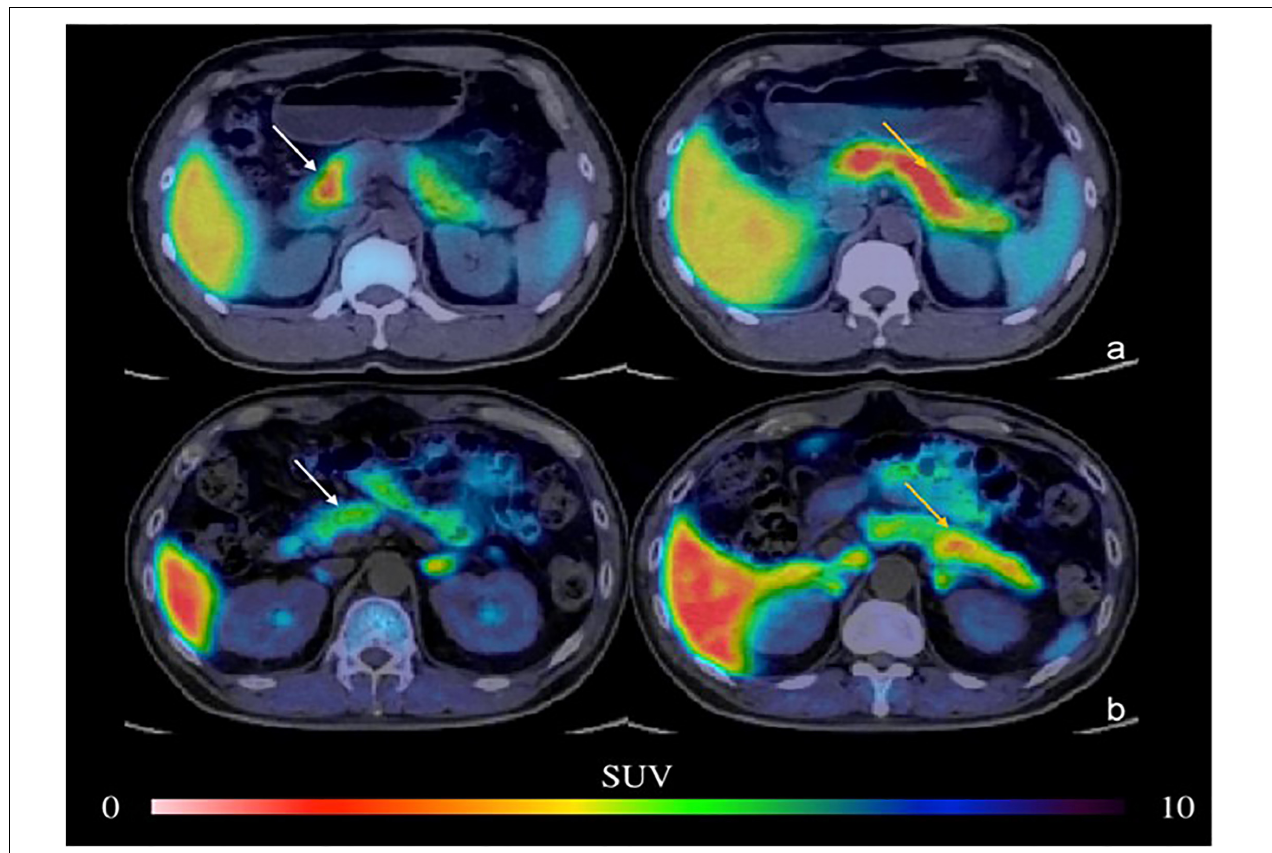
FIGURE 3 | PET imaging of the pancreas in type 2 DM (Donglang et al., 2018) (E-produced/adapted from Chin J Endocrinol Metab, used with permission) Representative PET imaging of the pancreatic head, body, and tail in the baboon in type 2 DM and in healthy controls. (a) Normal pancreas; (b) type 2 DM; white arrow, pancreatic head; yellow arrow, pancreatic body and tail; SUV, standardized uptake